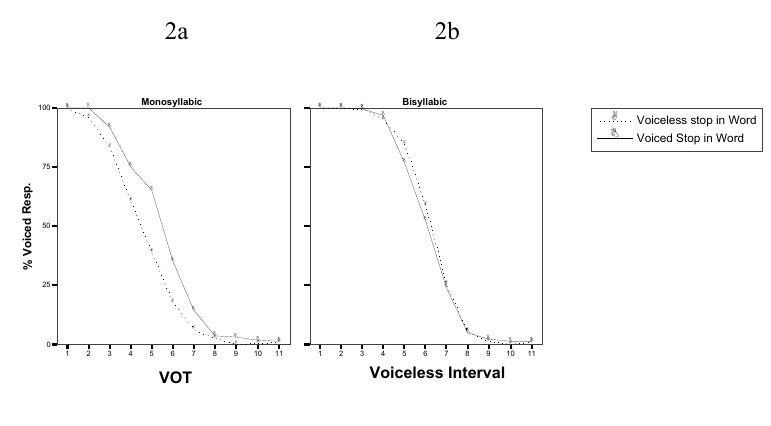
Figure 2: Results of Experiment 1. Mean percentages of voiced responses for the word-nonword monosyllabic continua (left) and for the bisyllabic ones (right). Responses for word-nonword continua for which an advantage for voiced responding was expected are indicated in continuous lines, those for which an advantage in voiceless responding was expected are indicated in broken